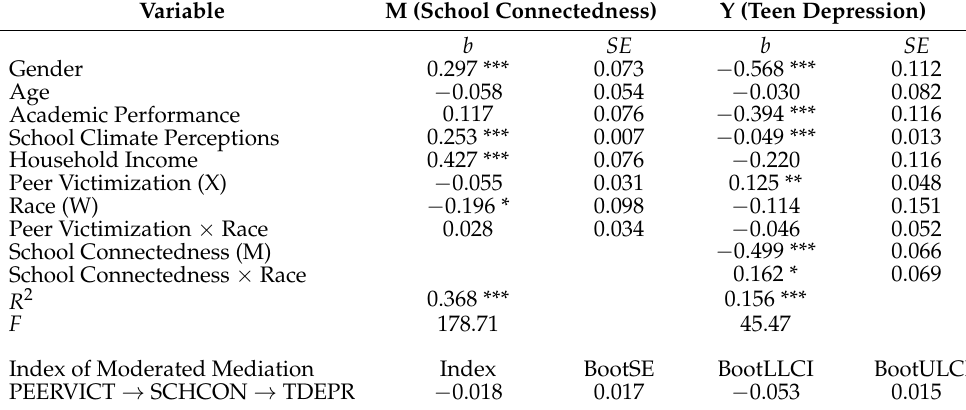
Table 2. Testing the moderated mediation effect of peer victimization on teen depression ( n = 2467).